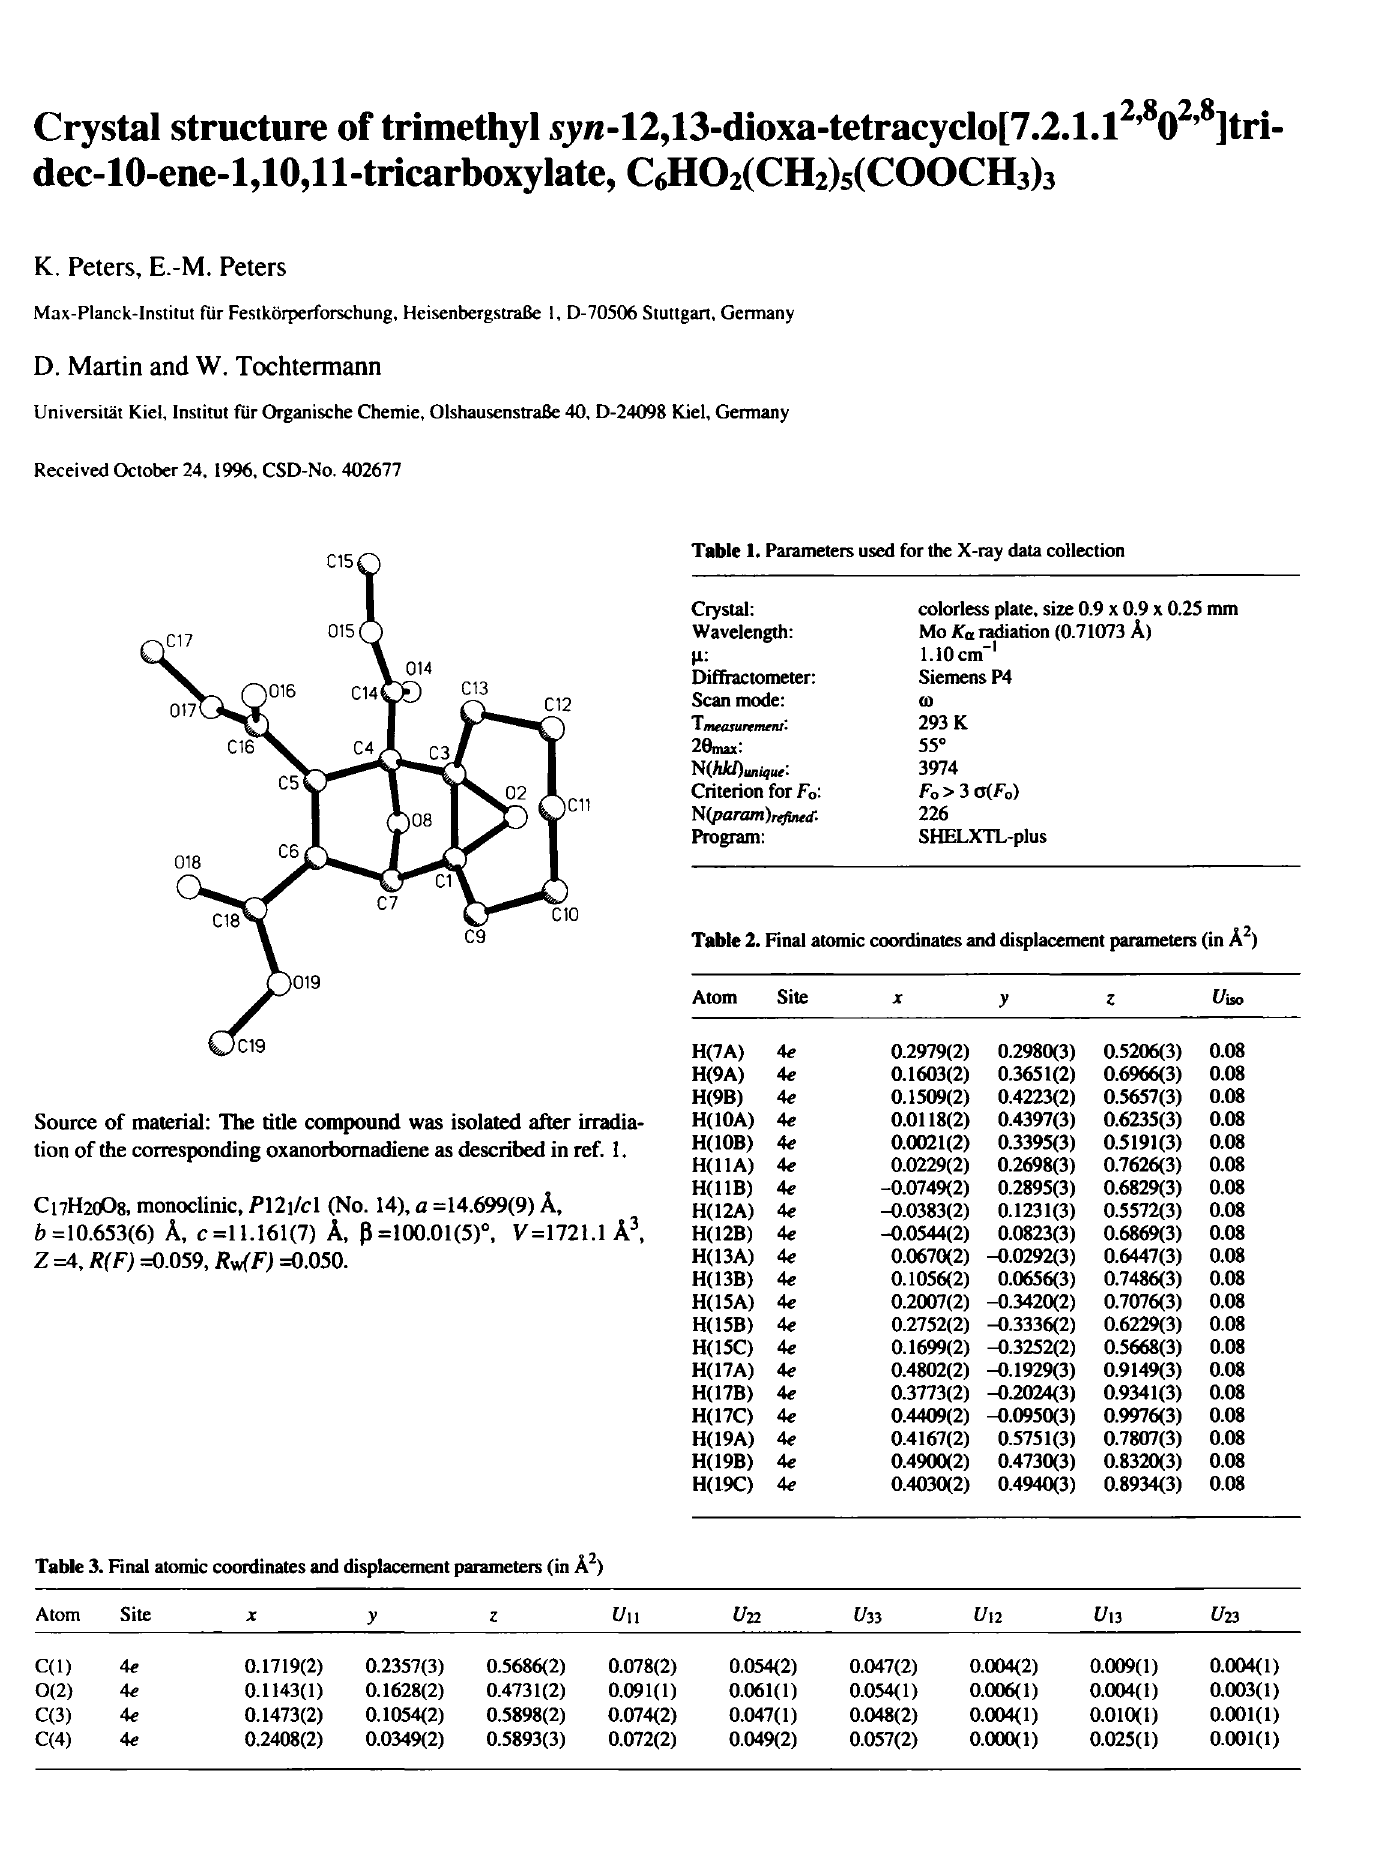
Table 1. Parameters used for the X-ray data collection